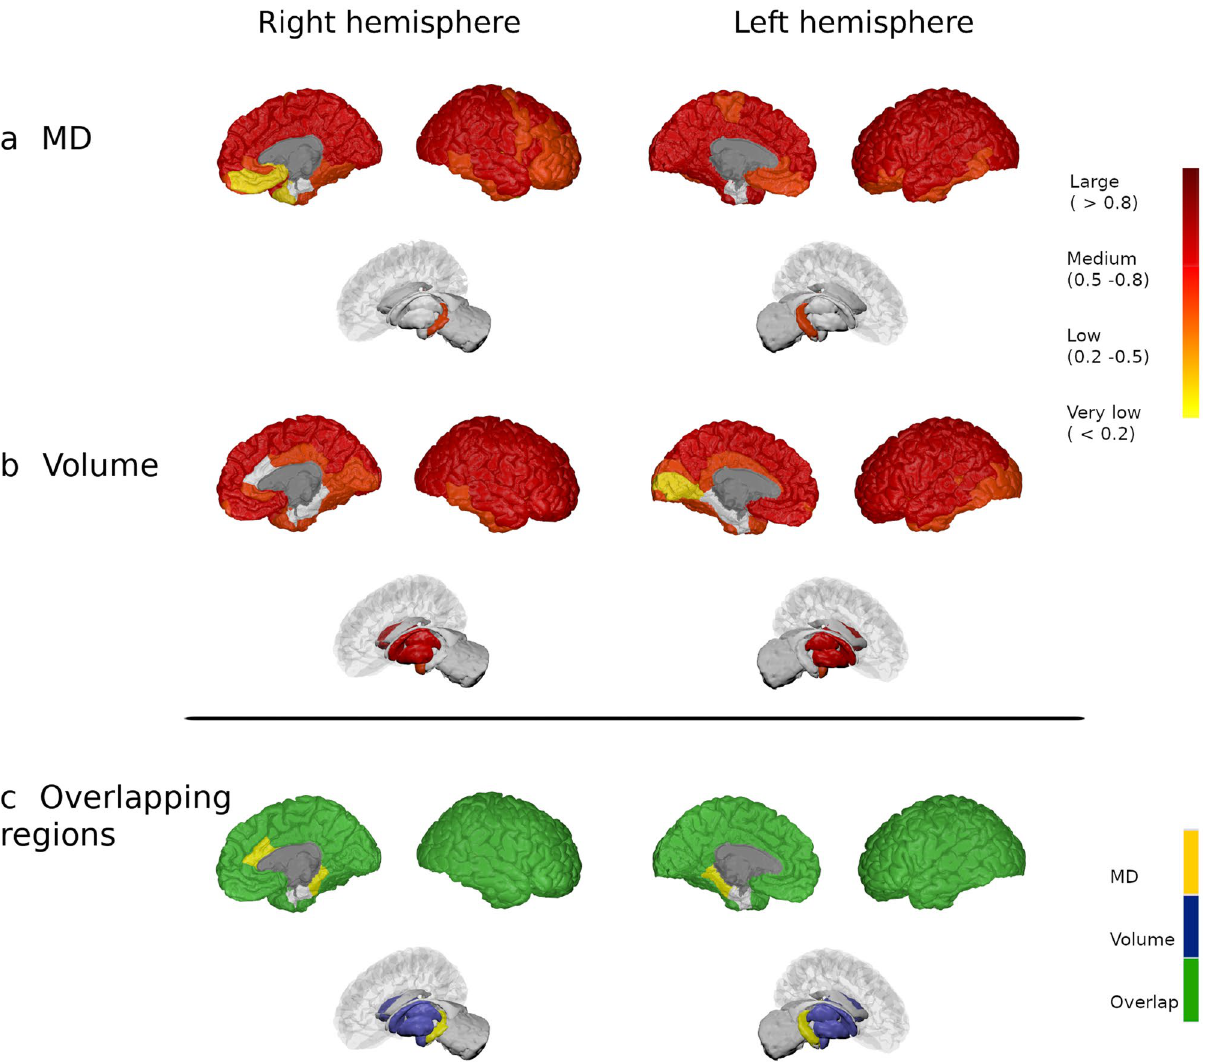
Figure 3. Modifications in patients with more than 15 years of disease duration. Differences in the grey matter mean diffusivity ( a ) and in volume ( b ) between MS patients from the MS3 group and HC. The colour gradient from yellow to red indicates the effect size ranges. The bottom figure shows the changes in MD (in yellow), volume (in blue) and their overlap (in green). The figure was generated using BrainPainter software 50